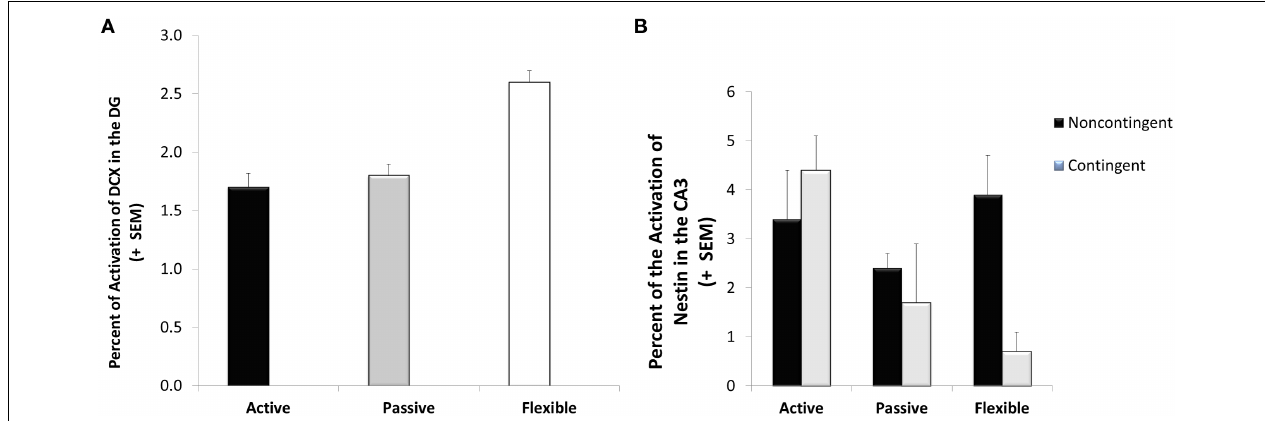
FIGURE 5 | Neuroplasticity markers. Doublecortin-immunoreactive tissue was higher in the flexible coping animals than their active and passive counterparts (A) whereas a significant interaction was observed in the